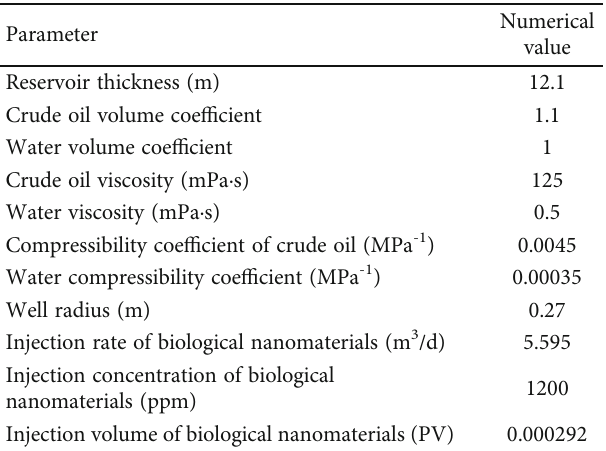
Table 1: Basic parameters of the reservoir and